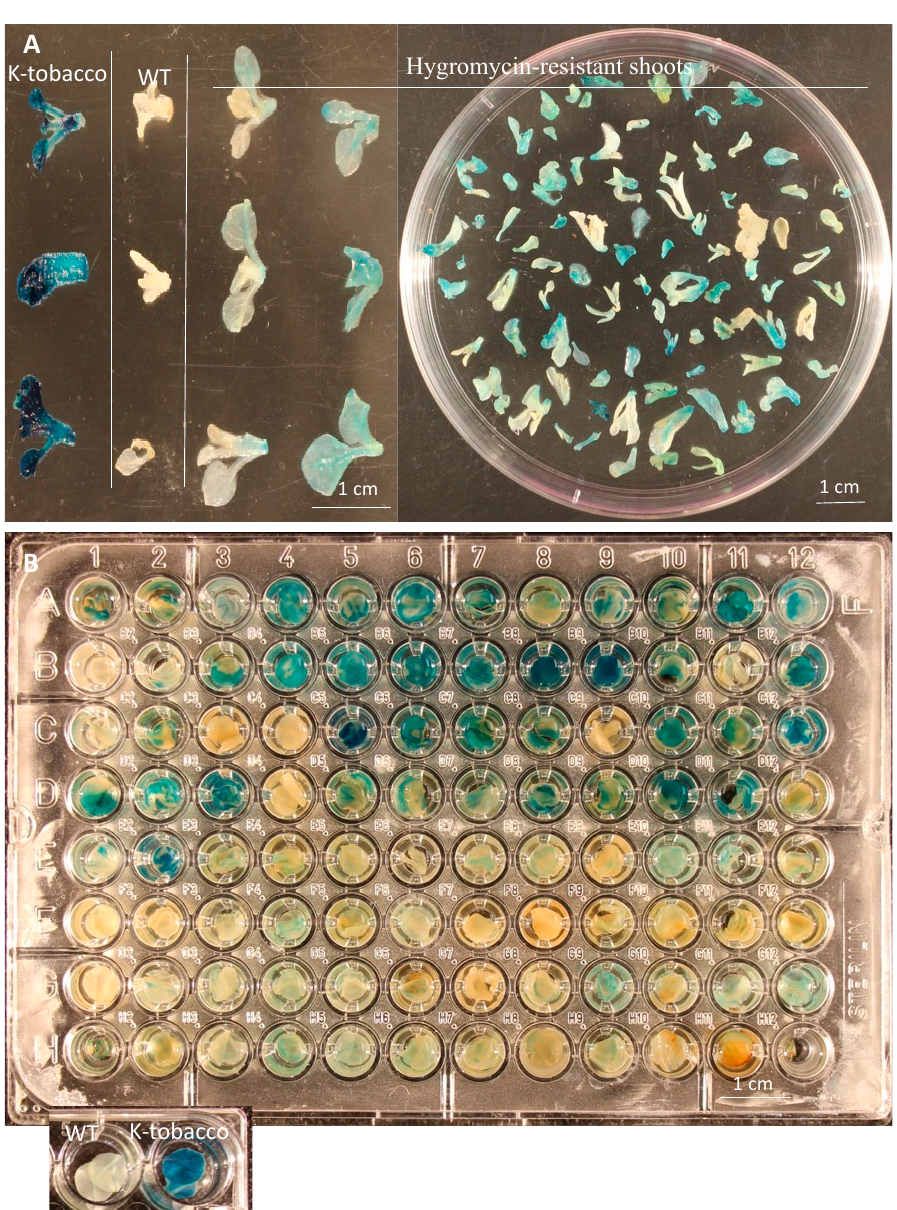
Figure 1. Histochemical GUS staining of tobacco tissues. ( A ) Hygromycin-resistant shoots each from different explants. ( B ) Leaf disks in individual wells were from 96 independent transgenic lines (hygromycin-resistant) containing the P35S-Cas9-GUS-gRNAs. WT: wild-type tobacco ‘Samsun’. K-tobacco: Kanamycin-resistant tobacco containing the pBISN1 vector with an active expressing gusA .